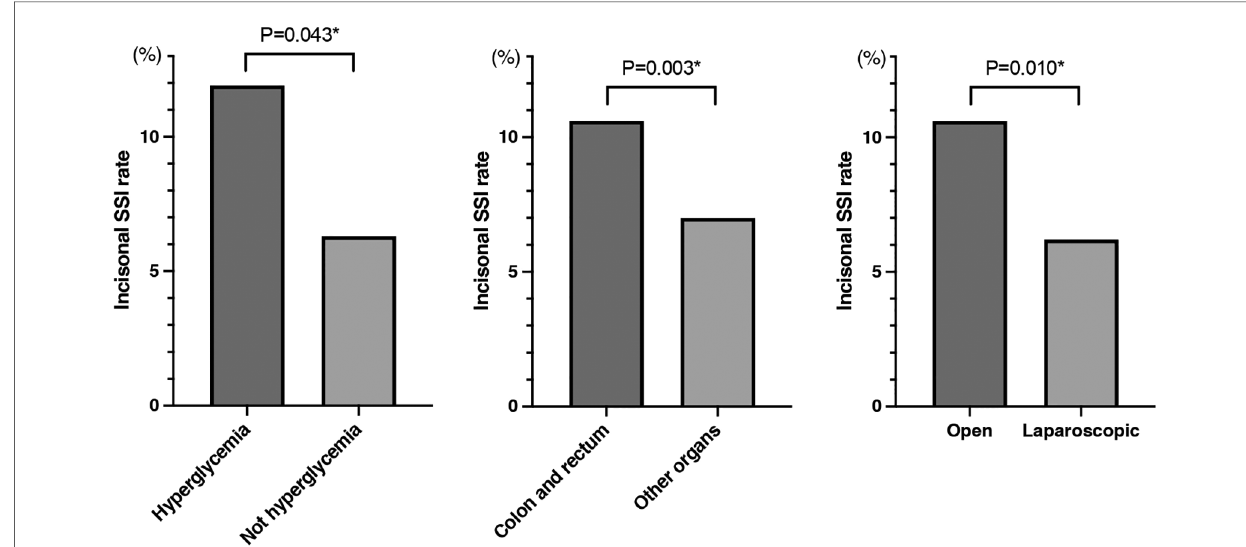
FIGURE 1 Comparison of the incisional SSI rate by glycemia status, affected organs, and surgical approach. SSI, surgical site infection